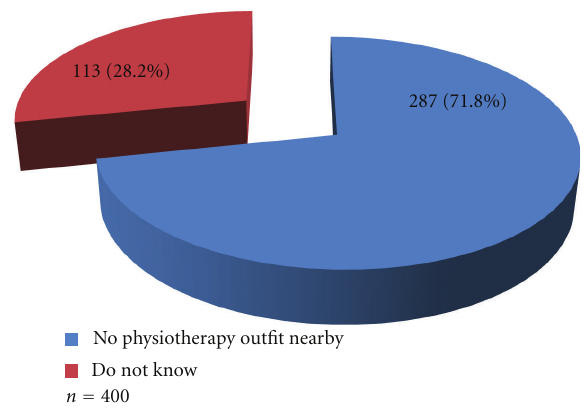
Figure 3: Availability of physiotherapy facilities within the commu-